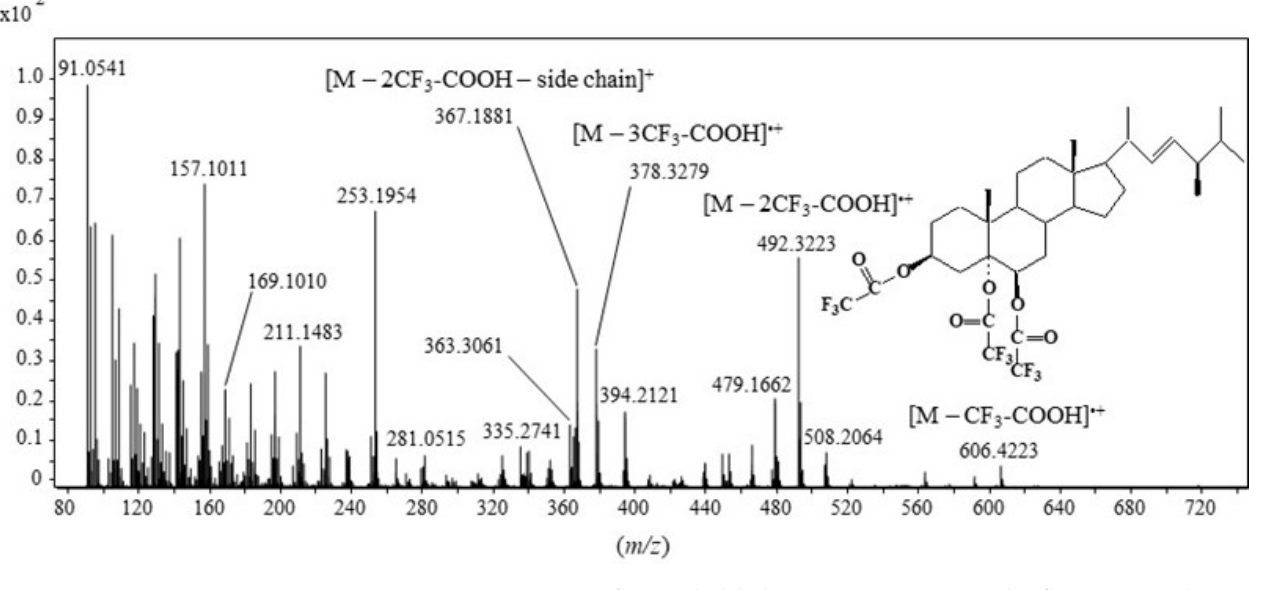
Figure 7. TOF mass spectrum of 24-methylcholest-22 E -en3 β ,5 α ,6 β -triol trifluoroacetate derivative.